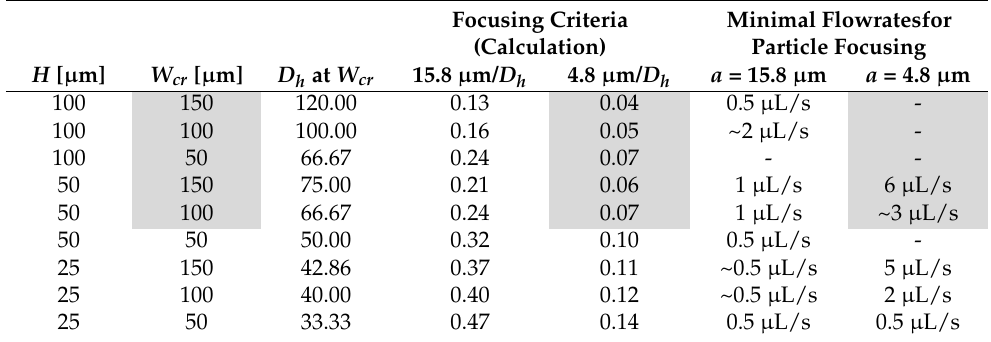
Table 1. Theoretical and experimental correlation on presence of lateral focusing effect. Shadow indicates the parameter sets which not complies the theoretical focusing criteria.